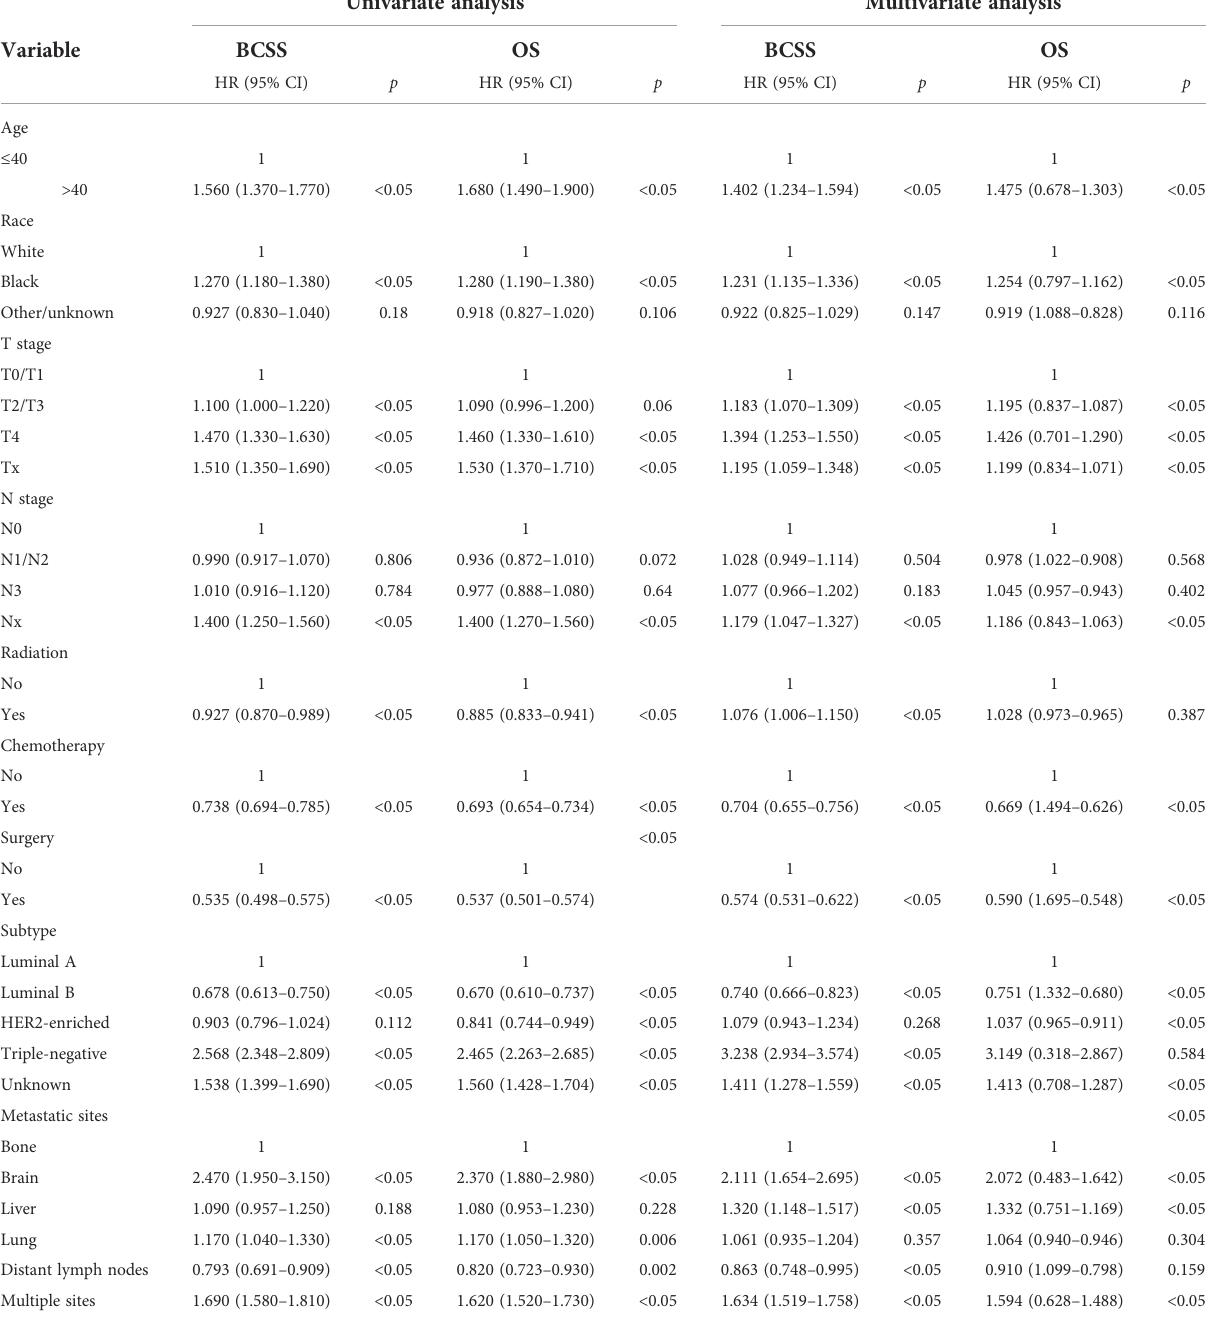
TABLE 2 Univariate and multivariate analyses of the overall survival (OS) and breast cancer-speci fi c survival (BCSS) of the study population. Univariate analysis Multivariate